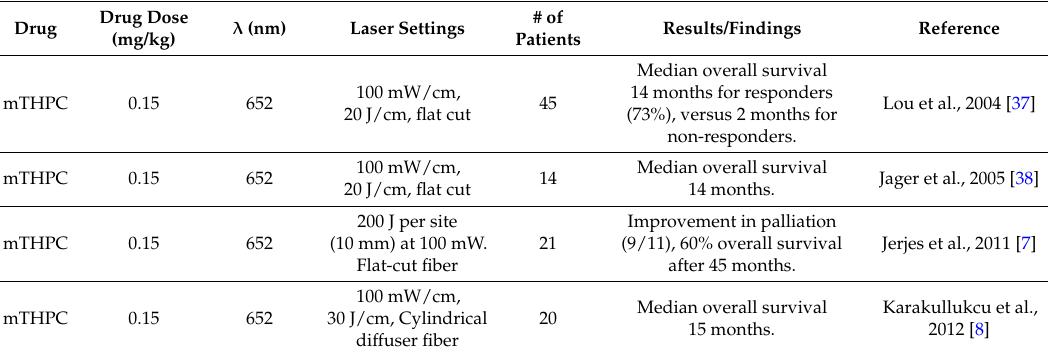
Table 3. Representative I-PDT treatments of head and neck